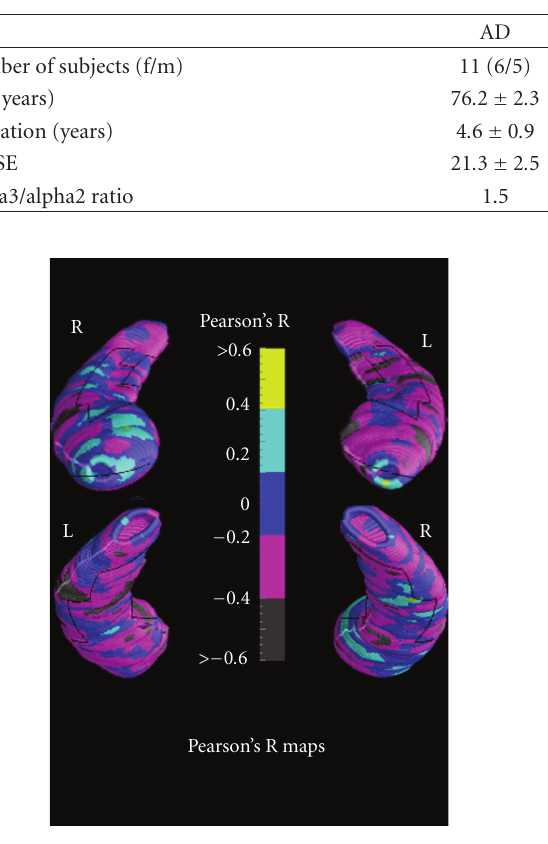
Table 3: Mean values ± standard deviation of sociodemographic characteristics, MMSE scores, and alpha3/alpha2 power ratio in AD cohort.